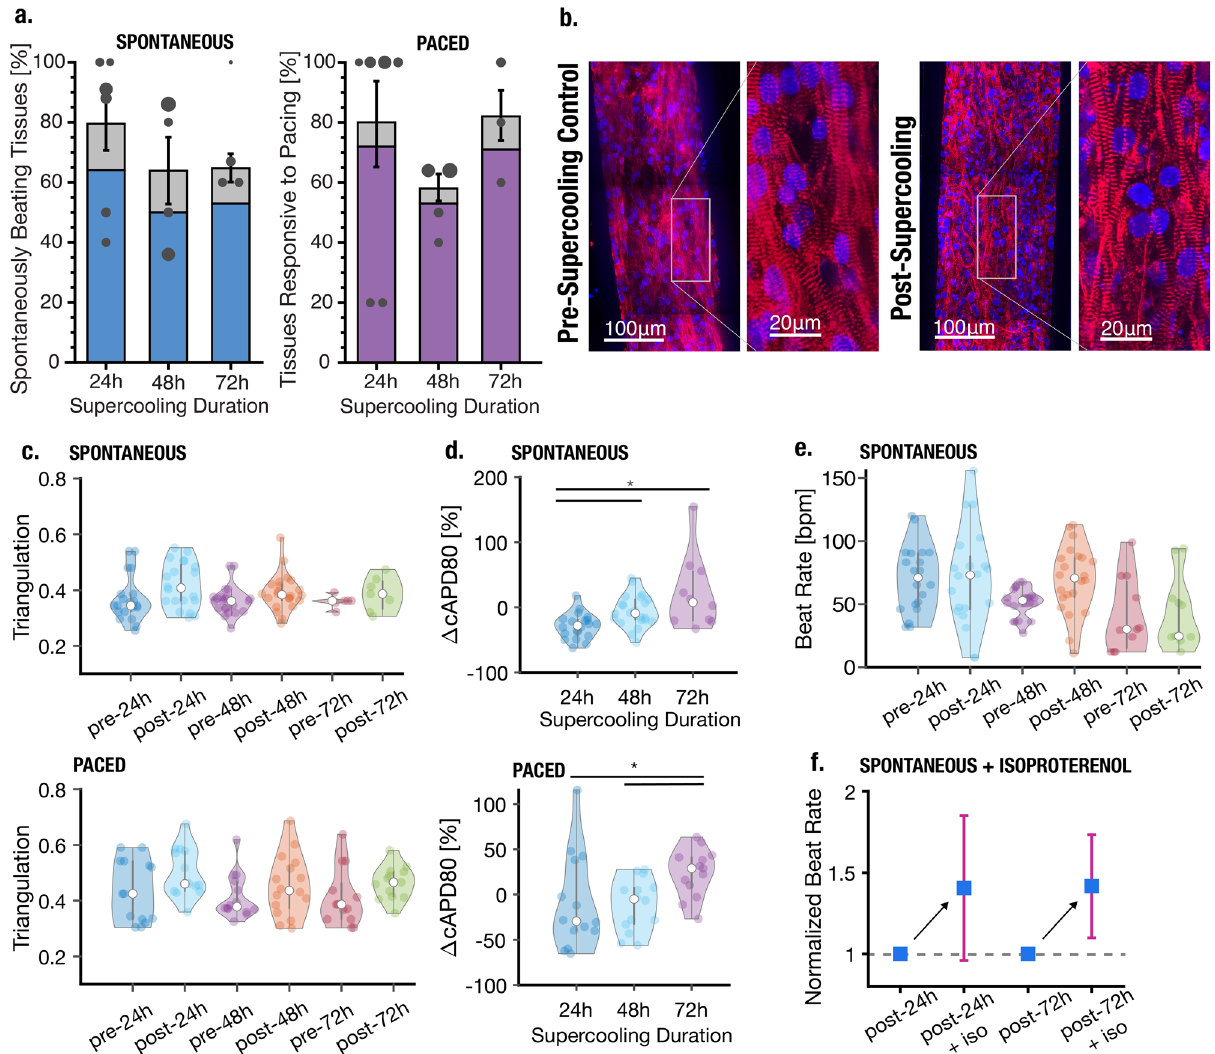
Fig. 2 Recovery rate and comparison of key cardiac functionality parameters pre- and post- isochoric supercooling. Statistical difference between groups ( p < 0.05) is marked by horizontal lines with asterisks. All raw data points are shown within violin plots. a Total recovery rate of preserved tissues as a function of preservation time. Gray bars indicate tissues that presented some activity post-isochoric supercooling, but were not coherent over the entire tissue (i.e., only part of the microtissue recovered). Scatter markers represent the weighted means of individual experiments, and marker diameter re fl ects the number of tissues (total sample sizes, i.e., number of independent cardiac tissues, for each condition: 24 h: n = 39; 48 h: n = 36; 72 h: n = 17). Error bars mark the standard error of the mean (SEM) across experimental groups, weighted by the total number of tissues evaluated in each group. These error bars re fl ect the SEM of the total surviving tissue population, i.e., the combined population of fully recovered and partially recovered tissues. b Confocal microscopy image of cardiac microtissue before and after 24 h supercooled preservation ( α -actinin in red and nuclei in blue). c Triangulation ((APD80-APD30)/APD80) as a metric of beat shape following 24, 48, or 72 h isochoric supercooling. All raw data points are scatter plotted within the violin plots. d Percent change in beat rate-corrected APD80 of recovered tissues compared to pre-isochoric supercooling. e Spontaneous beat rate of recovered tissues. f Increase in normalized beat rate upon introduction of 1 μ M isoproterenol for 30 min to tissues that had previously been subjected to 24 h (left) or 72 h (right) supercooled preservation (sample sizes: 24 h: n = 6; 72 h: n =